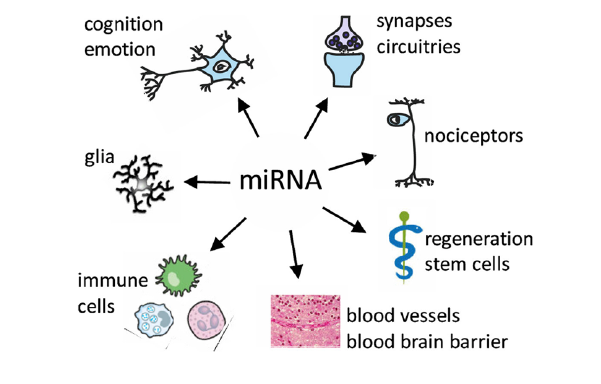
FIGURE 1 |Targets of miRNA regulation